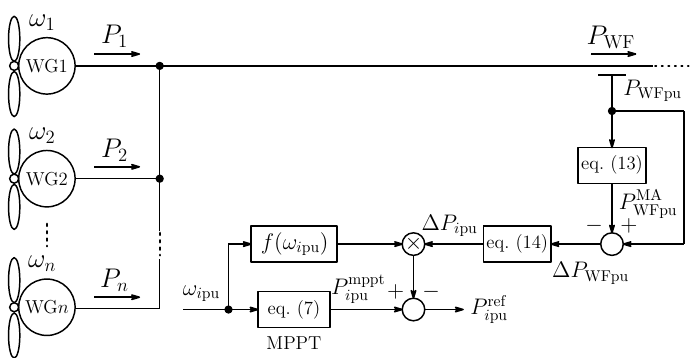
Figure 4. The standard moving average kinetic energy